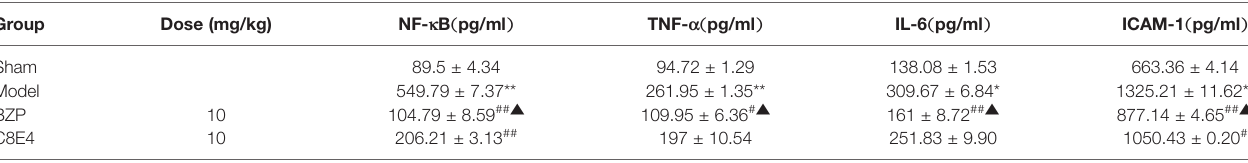
TABLE 4 | Effect of BZP on the expression of NF- k B, TNF- a , IL-6, and ICAM-1 in MCAO rats. Group